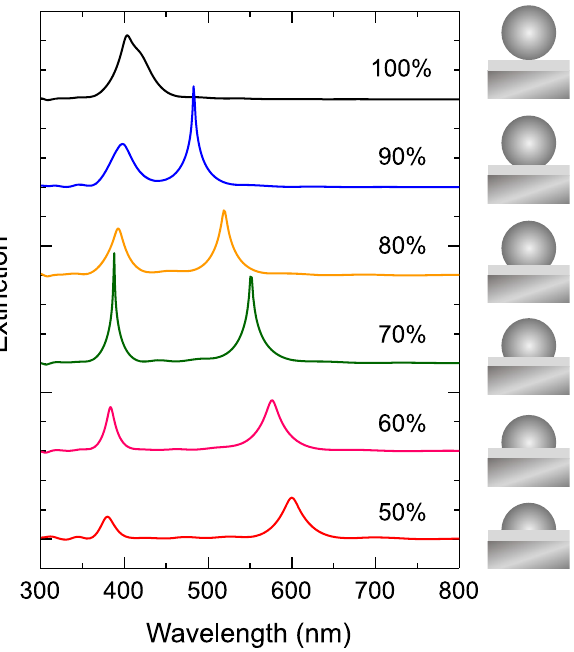
Figure 5: Dependency on the extinction spectra of the various shapes of the nanohemisphere on mirror (NHoM) (spherical (100%) to hemispherical (50%)) obtained with finite difference time domain (FDTD)